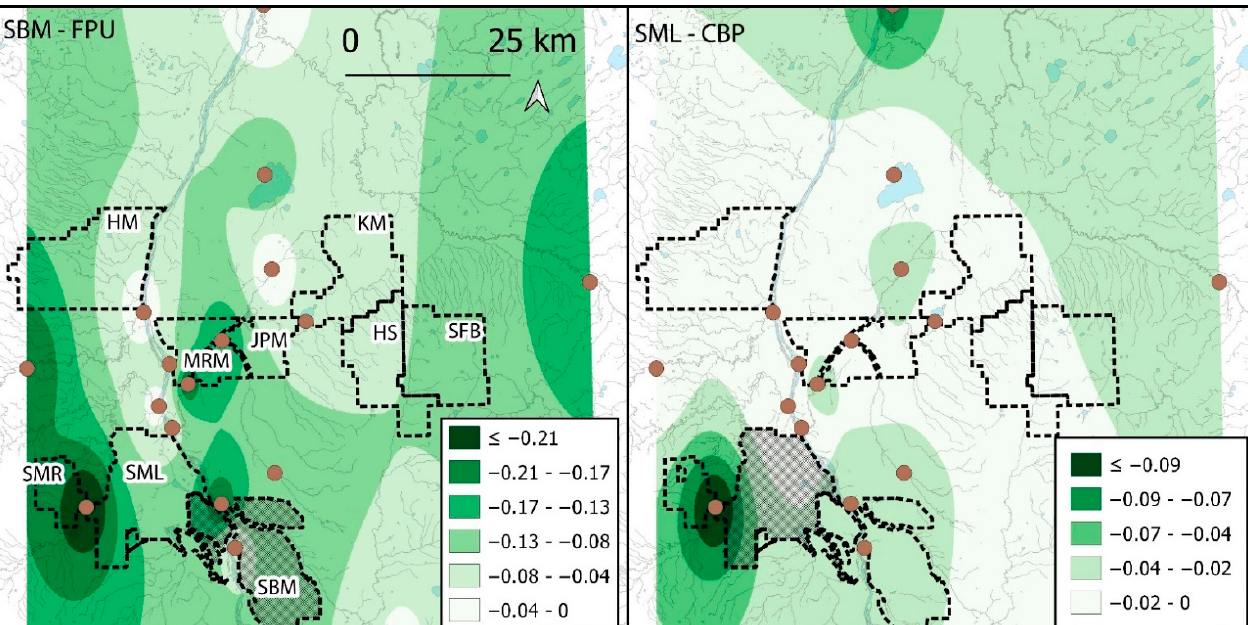
Figure 2. Spatially interpolated (IDW; distance coefficient = 2) surface of β coefficient magnitudes for the two most commonly selected industrial variables: SBM-FPU ( left pane; SBM highlighted with grey cross-hatching) and SML-CBP ( right pane; SML highlighted with grey cross-hatching) with negative effects on benthic macroinvertebrate indices (BMIIs) TA, TR, EPT, and EQ; “0” values were included for site-index combinations when SBM-FPU or SML-CBP were not selected; circles show locations of benthic invertebrate sampling sites.